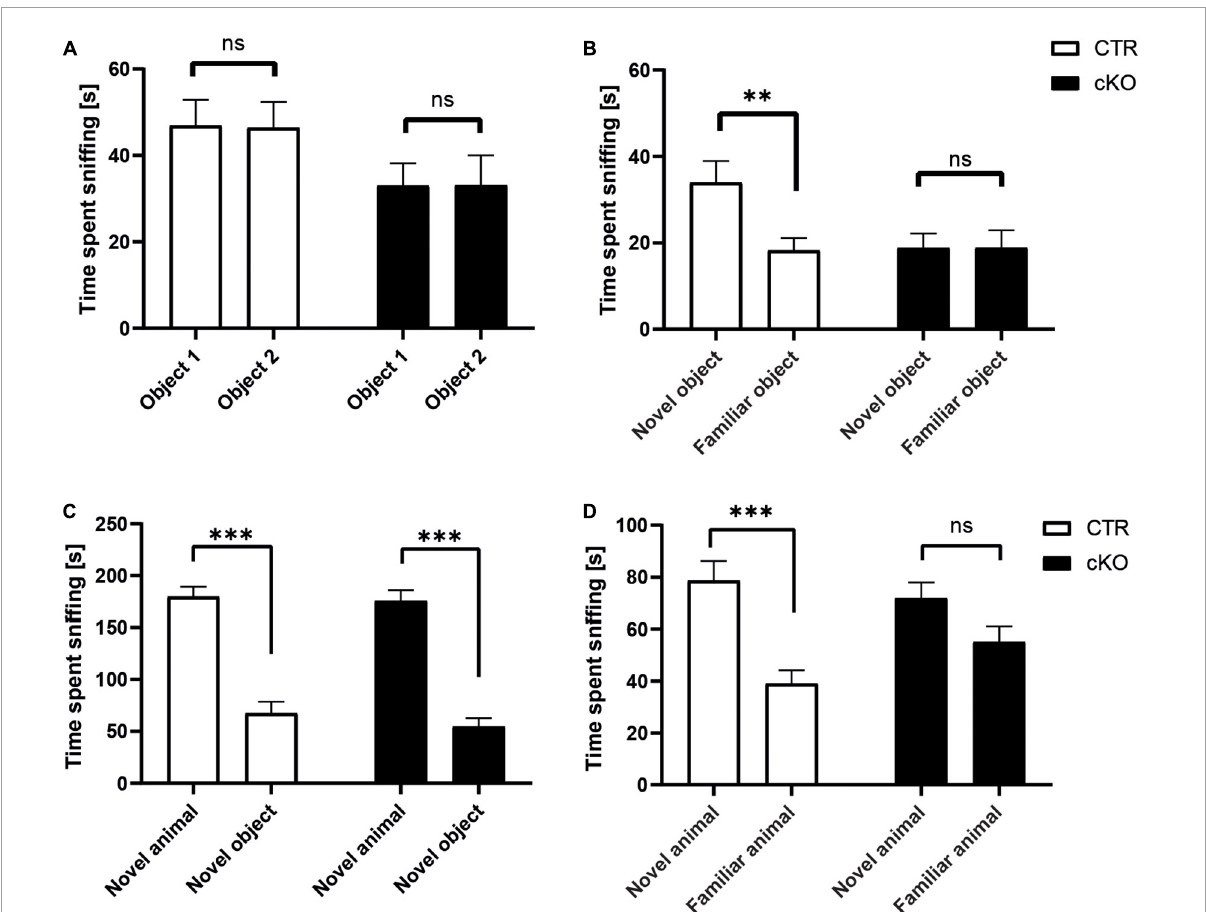
FIGURE2 Normal social approach, but reduced social and object recognition in juvenile cKO mice. Graphs showing (A) time spent sniffing two identical objects (s), CTR: object 1: 46.9 ± 5.9, object 2: 46.4 ± 5.9, t 31 = 0.135, p = 0.893, n = 32; cKO: object 1: 33.0 ± 5.1, object 2: 33.1 ± 6.9, t 35 = 0.018, p = 0.986, n = 36. (B) Time spent sniffing novel and familiar object (s), CTR: novel: 34.0 ± 5.0, familiar: 18.3 ± 2.8, t 31 = 3.226, p < 0.01; cKO: novel: 18.8 ± 3.3, familiar: 18.9 ± 5.3, t 35 = 0.008, p = 0.994. (C) Time spent sniffing social and non-social stimulus (s), CTR: social: 179.7 ± 12.2, non-social: 67.6 ± 11.1, t 37 = 5.854, p < 0.001; cKO: social: 175.7 ± 15.7, non-social: 54.8 ± 8.2, t 37 = 6.673, p < 0.001. (D) Time spent sniffing novel and familiar social stimulus (s), CTR: novel: 78.7 ± 8.6, familiar: 39.1 ± 5.1, t 37 = 3.983, p < 0.001; cKO: novel: 72.0 ± 8.1, familiar: 55.1 ± 8.1, t 37 = 1.280, p = 0.209. ns: p = 0.05, ** p < 0.01, *** p <